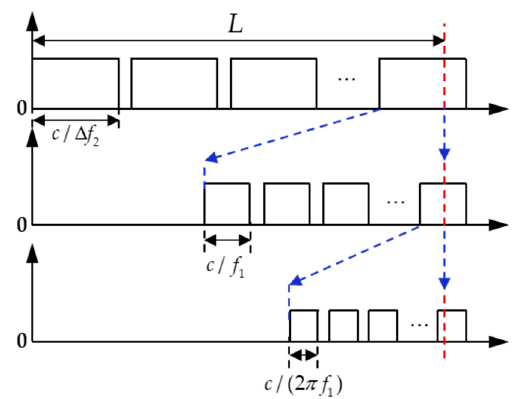
Figure 13. The working mechanism of the MFCW algorithm where L represented the overall distance to be measured between transmitter and receiver.